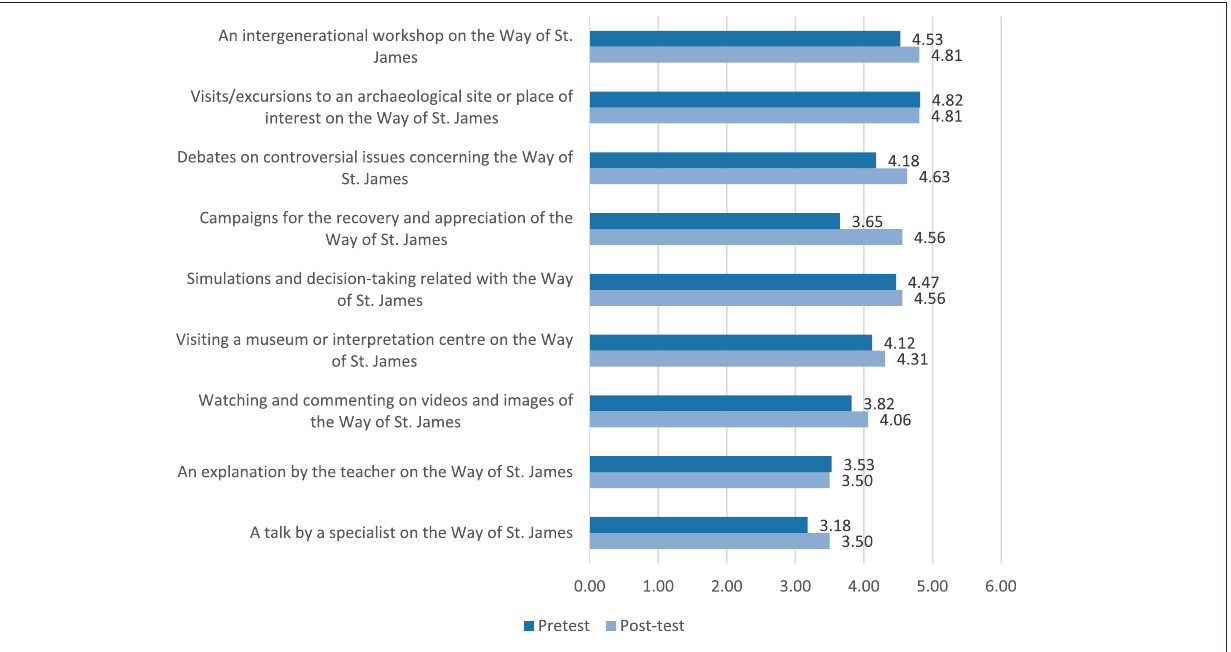
FIGURE 6 | Teaching activities for the raising of awareness about the Way of St. James in primary